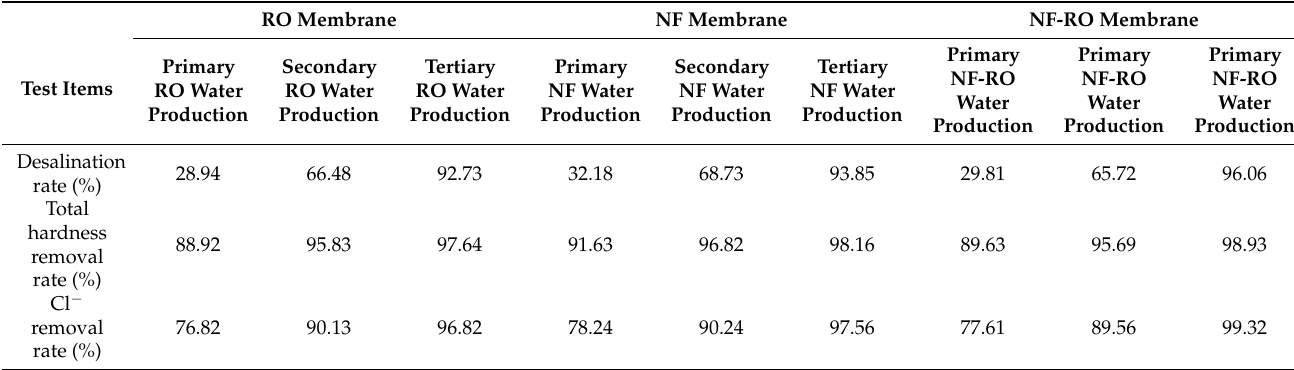
Table 2. Filtration effect of nanofiltration reverse osmosis